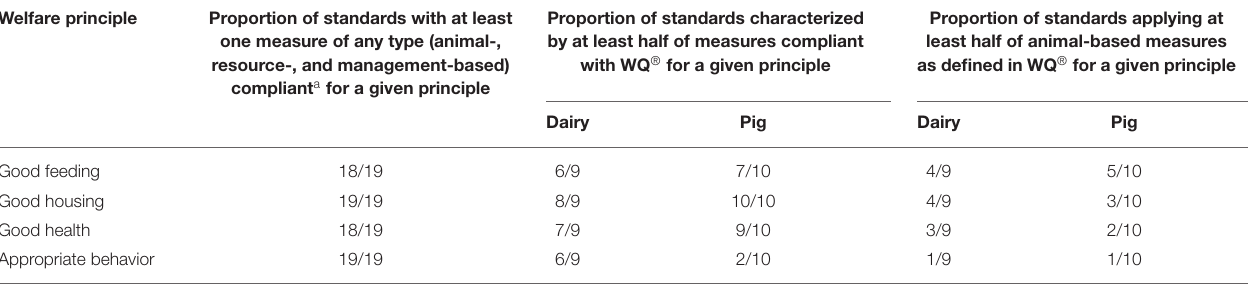
TABLE 2 | The coverage of welfare principles (good feeding, good housing, good health, and appropriate behavior) by analyzed schemes. Welfare